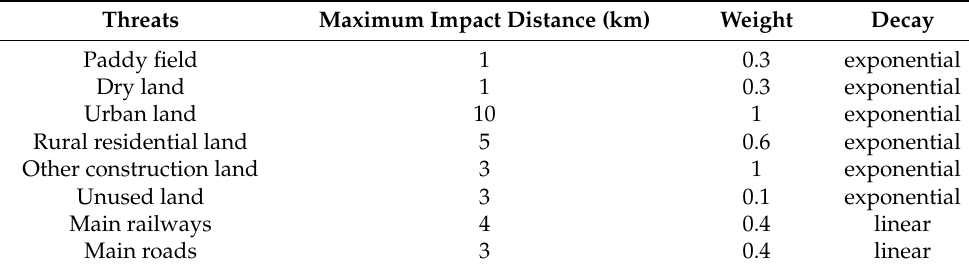
Table 2. Threats and their maximum distance of influence and weight.